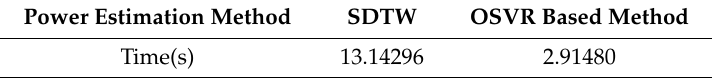
Table 8. Computation time for power consumption estimation.